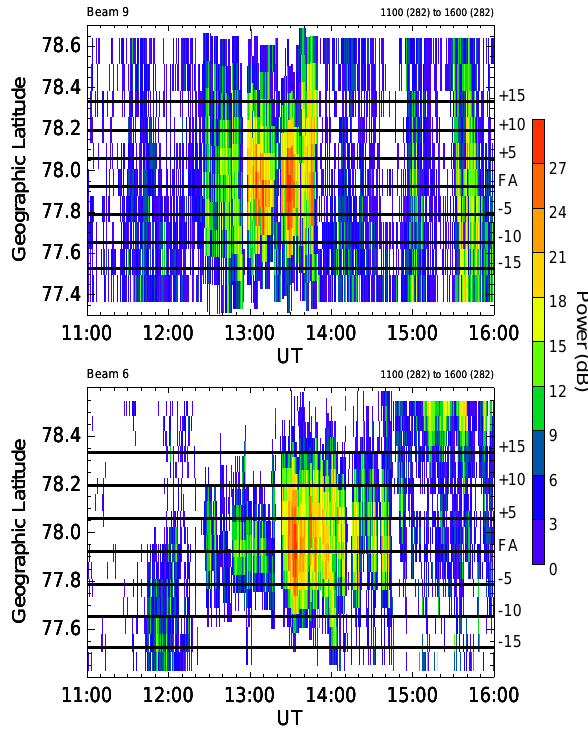
Fig. 6. A range-time-intensity plot of the repositioned CUTLASS backscatter power from 9 October 2006 (interval 2). The upper and lower panels show data from Finland Channel A (beam 9) and Ice- land Channel A (beam 6) respectively. The horizontal black bars in each panel show the overlaid geographic latitudes, calculated using a typical interaction altitude of 180km, corresponding to the seven ESR pointing directions. The SPEAR beam pointed field-aligned and this corresponds to the highest backscatter power, with appre- ciably lower powers for pointing directions furthest from FA, i.e. FA ± 10 and FA ±